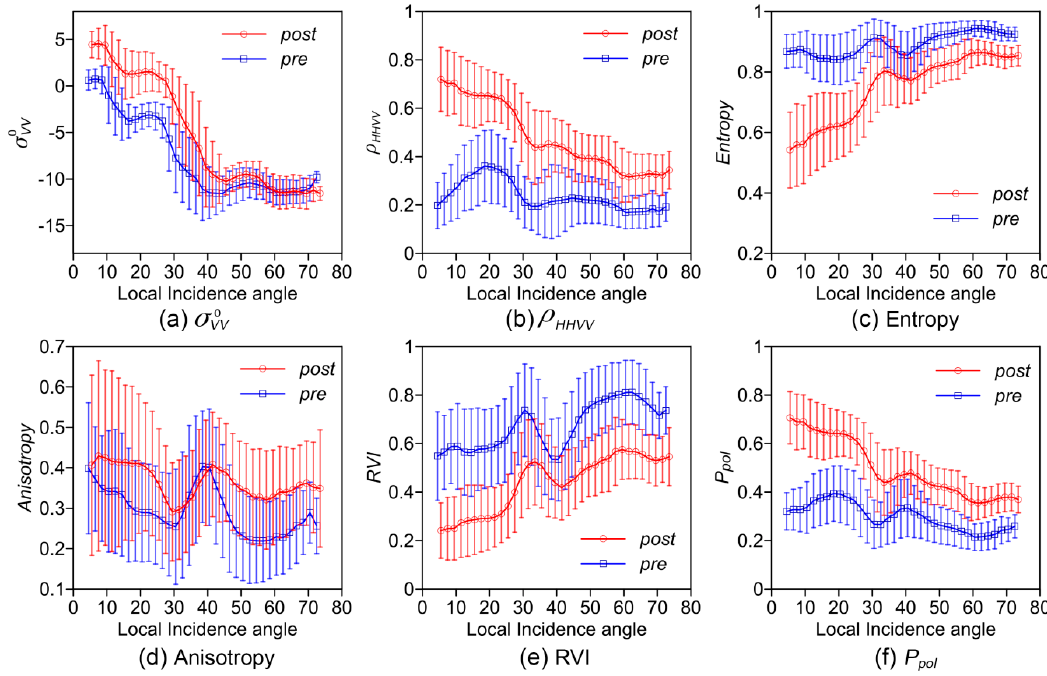
Figure 5. Changes of the polarimetric parameters ( a ) σ 0 , ( b ) ρ HHVV , ( c ) entropy, ( d ) anisotropy, ( e ) Radar Vegetation Index (RVI), and ( f ) P pol in forested areas with respect to the local incidence